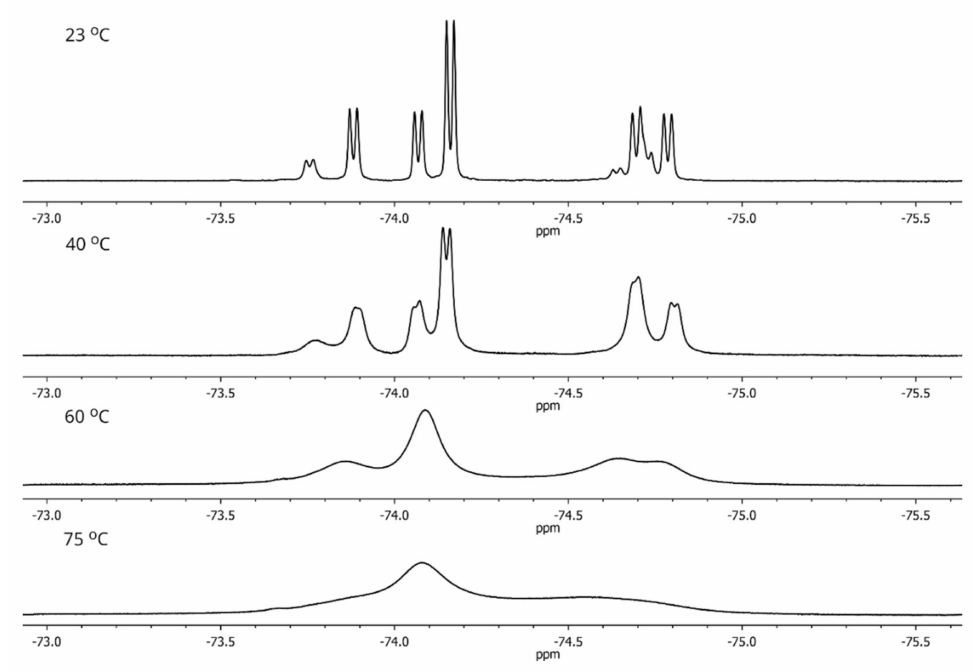
Figure 11. Temperature dependence of 19 F NMR spectra of two diastereomers of 1 in toluene-d 8 .